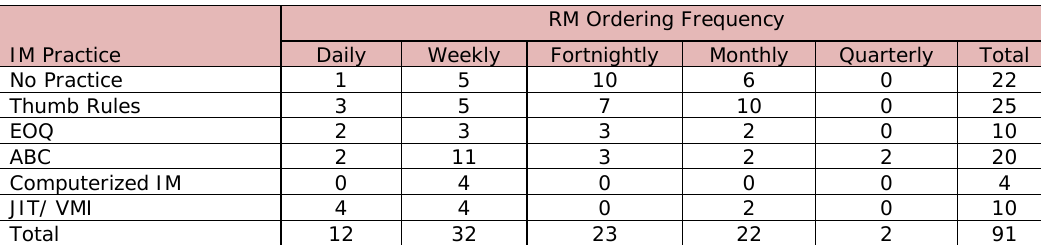
Table 2. “IM Practices and Raw Material Ordering